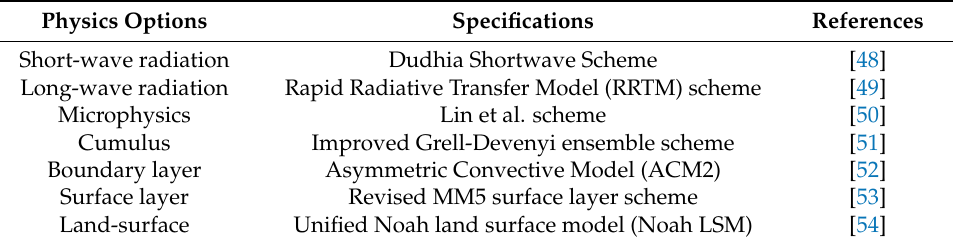
Table 1. Model physics options.